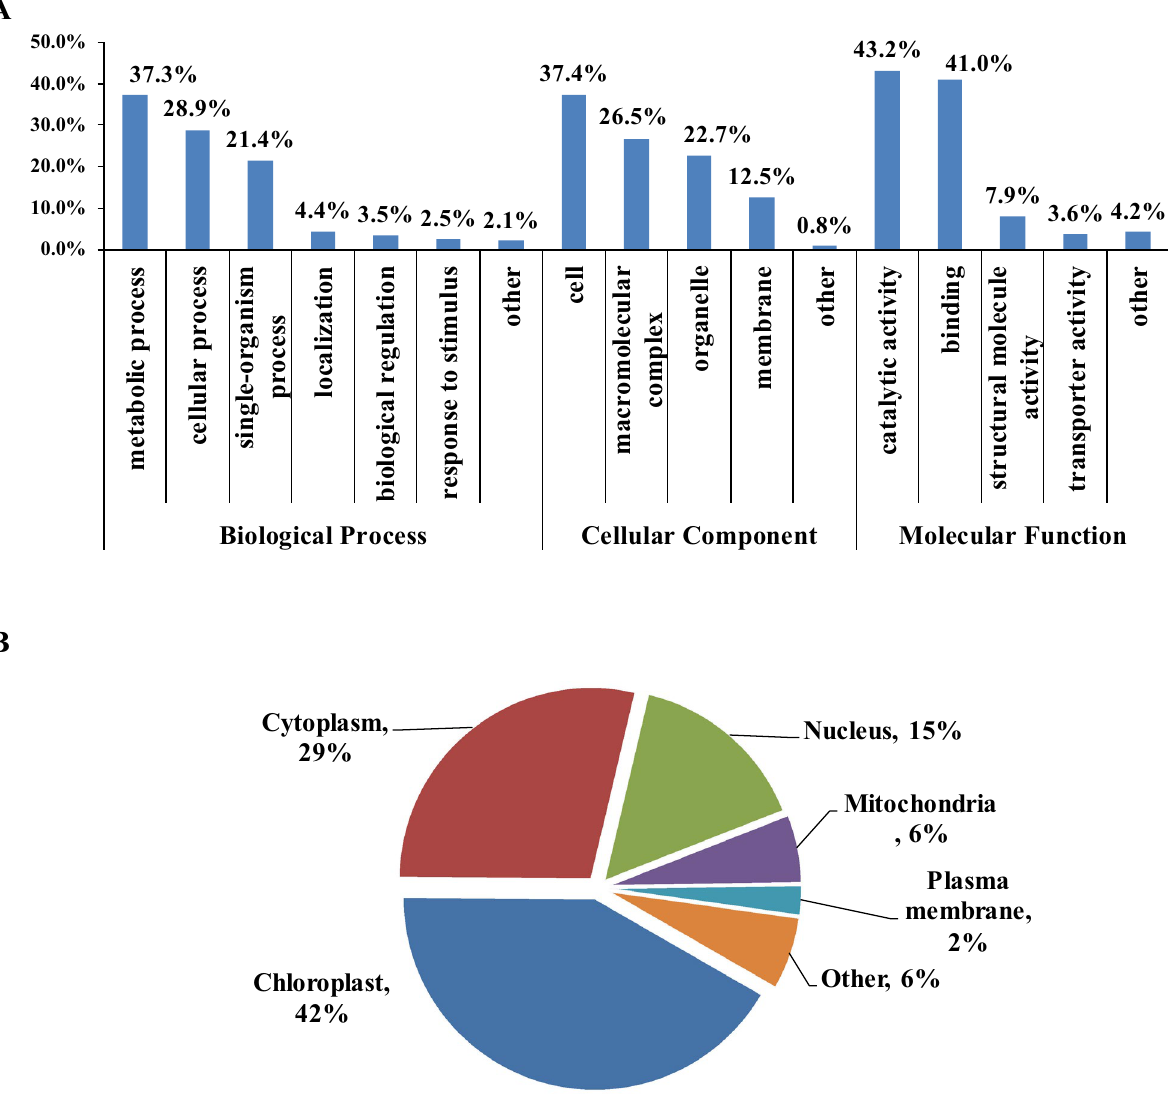
Figure 3. Functional classification and subcellular localization of the Kac proteins in soybean leaves. ( A ) GO annotation based classification. ( B ) Subcellular location